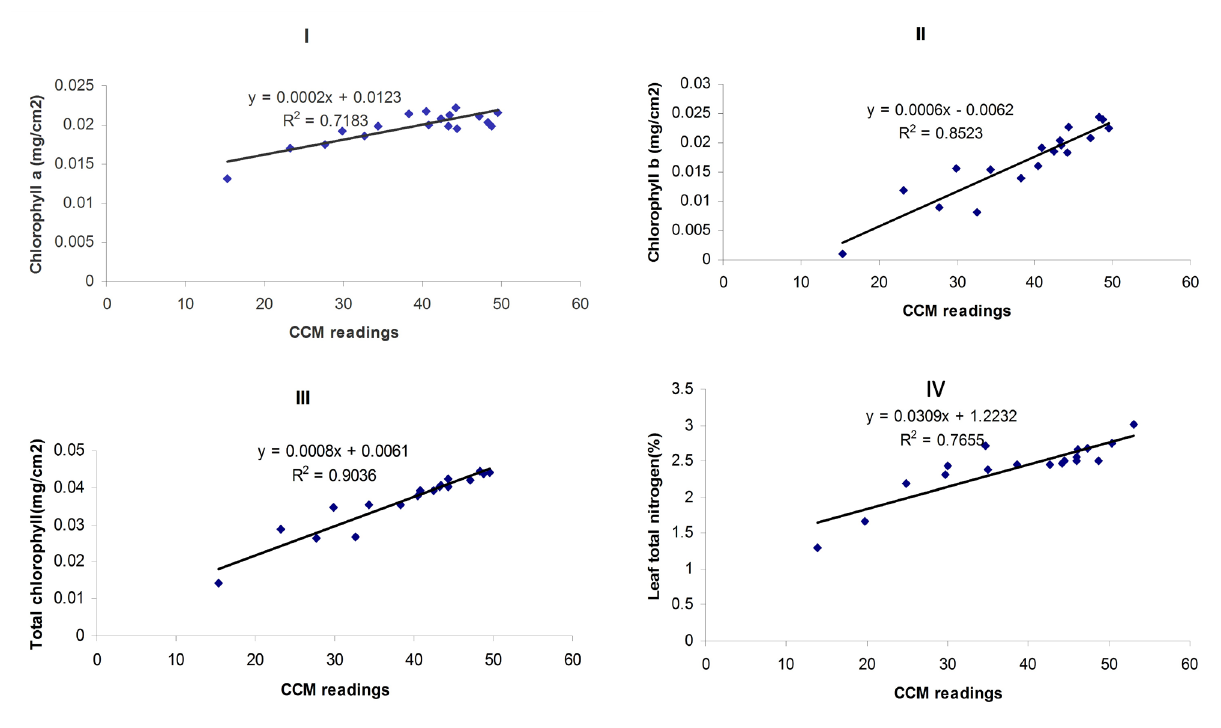
Fig.1. The linear correlation between chlorophyll meter readings and chlorophyll a , b , total chlorophyll content and total nitrogen (I,II, III and IV) in Asian pear leaves. Each point is average 12